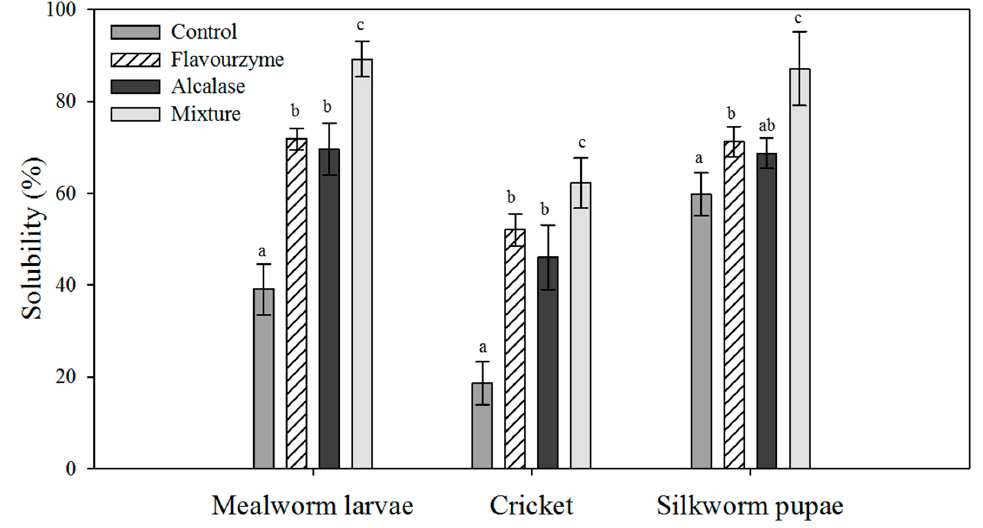
Figure 3. The solubility of insect proteins before and after enzymatic hydrolysis. Each value is expressed as the mean ± standard deviation (SD) ( n = 3). Values marked with different letters indicate significant differences among treated groups ( p < 0.05).